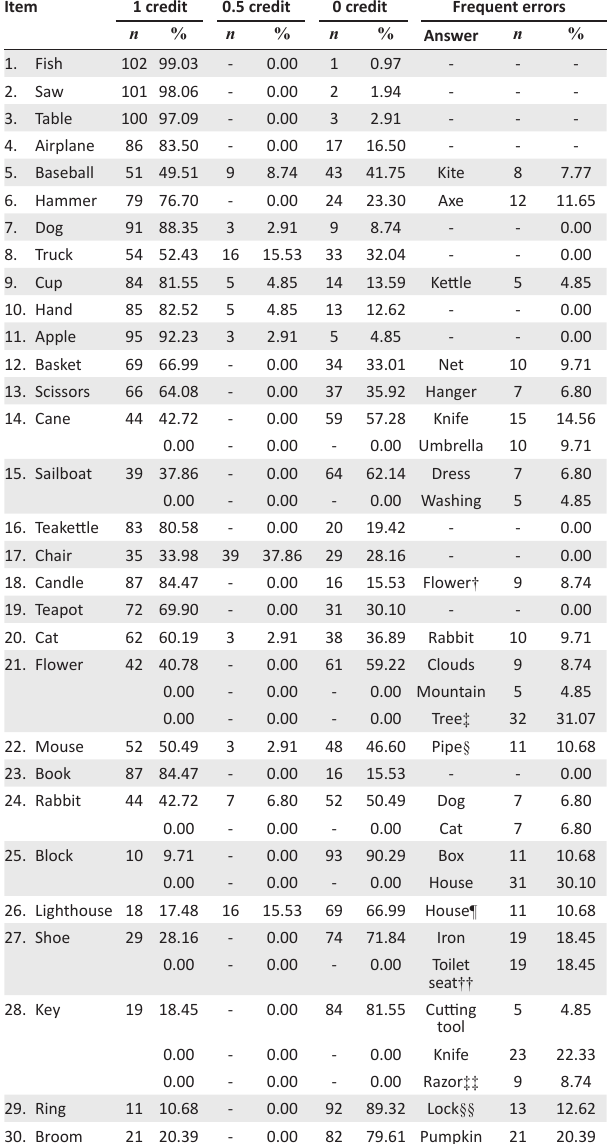
TABLE 5: Pearson correlation coefficient showing the relationship between the Hooper Visual Organization Test total score and different subtests of the Montreal Cognitive Assessment.